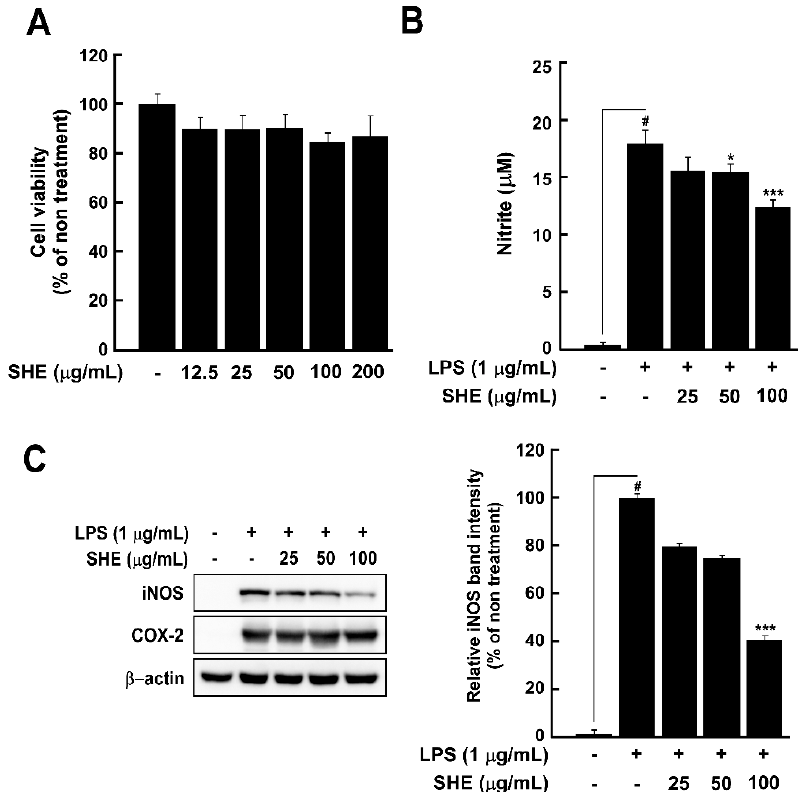
Figure 1. Effects of Soroseris hirsuta extract (SHE) on lipopolysaccharide (LPS)-induced nitrite pro- duction, inducible nitric oxide synthase (iNOS) and cyclooxygenase-2 (COX-2) expressions, and cell viability in RAW 264.7 cells. ( A ) SHE does not incur toxicity to RAW 264.7 cells at the given concentration for 24 h. ( B ) SHE effectively inhibited the increased nitrite from LPS treatment in a concentration-dependent manner to RAW 264.7 cells. ( C ) LPS-induced iNOS expression was sup- pressed by SHE treatment, but COX-2 did not. Cells were treated with SHE 1 h before exposure to LPS for 24 h. # p < 0.05 between the LPS-only group and the control group; * p < 0.05 and *** p < 0.001 between the SHE and LPS co-treatment groups and the LPS-only group. Data are presented as the mean ± SD from n =